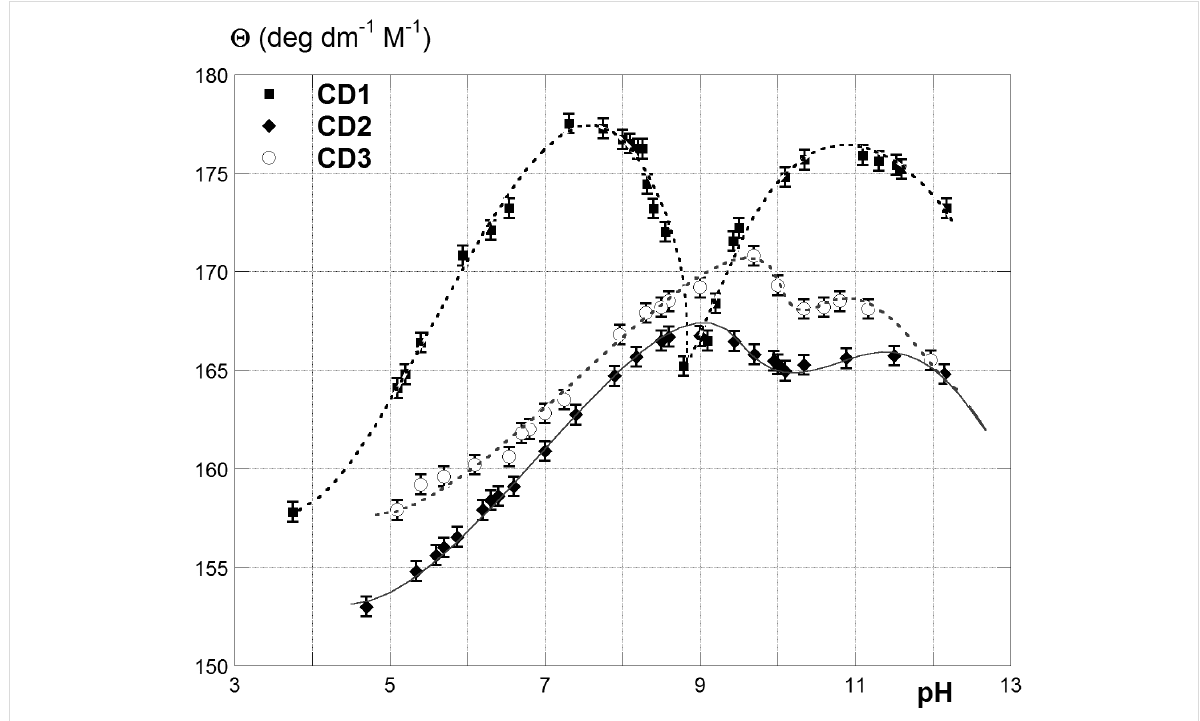
Figure 2: Trends of the molar optical rotation Θ of AmCDs CD1 – 3 vs